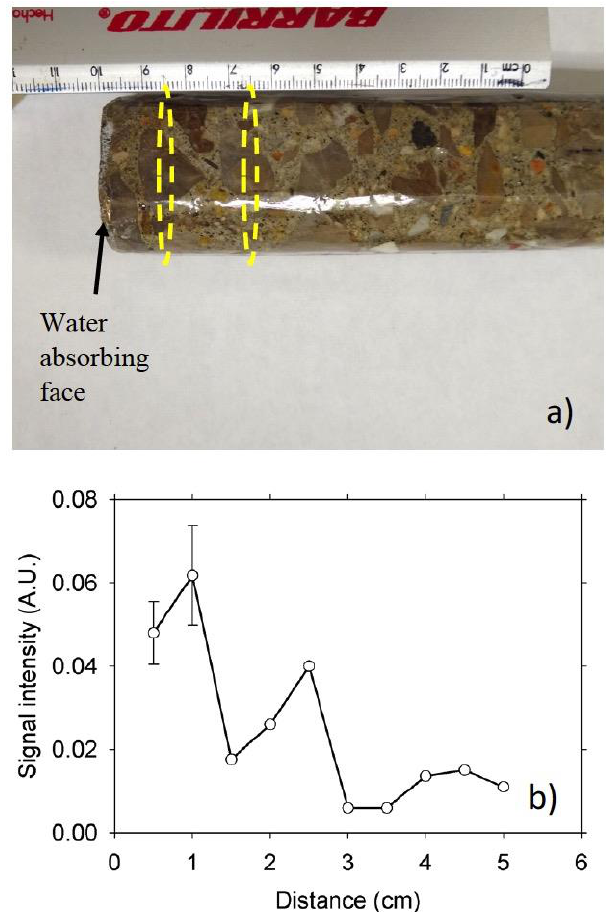
Figure 11. ( a ) Photograph of the 0.60 w/c ratio concrete sample. The dotted ellipses show the approximate position of the RF coil during the NMR measurements at positions 1.5 and 3.5 cm where the presence of coarse aggregates reduced the signal intensity, and ( b ) CPMG signal intensity after five days of water absorption. The sample error bars represent the uncertainty in the estimation of the intensity.